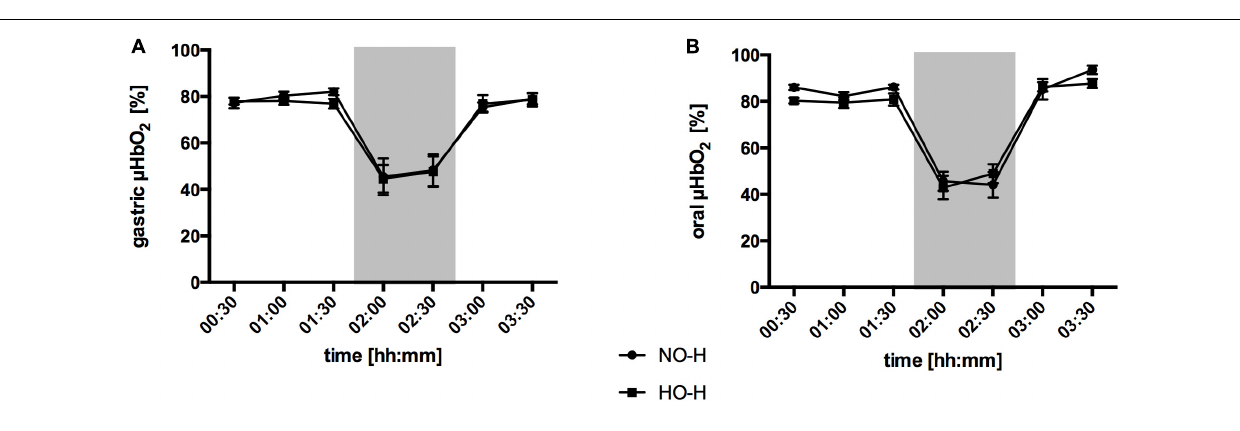
FIGURE 4 | Effect of local oxygen application on microvascular oxygenation: Microvascular oxygenation ( µ HbO 2 ) in percentage (%) at the gastric (A) and oral (B) mucosa. The animals received a continuous gas application with either N 2 to maintain local normoxia (NO-H) or O 2 for local hyperoxia (HO-H) followed by hemorrhage and retransfusion. One hour of acute hemorrhage is marked grey. Data are presented as mean SEM for n = 6